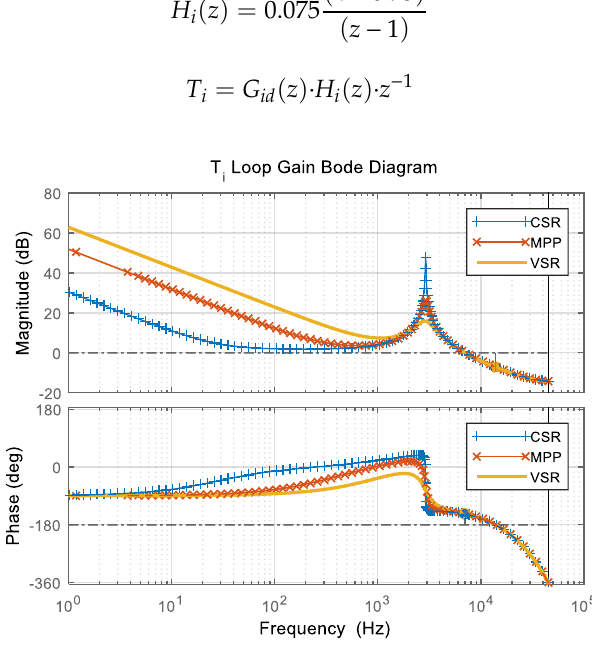
Figure 10. Bode diagram of open-loop current gain.